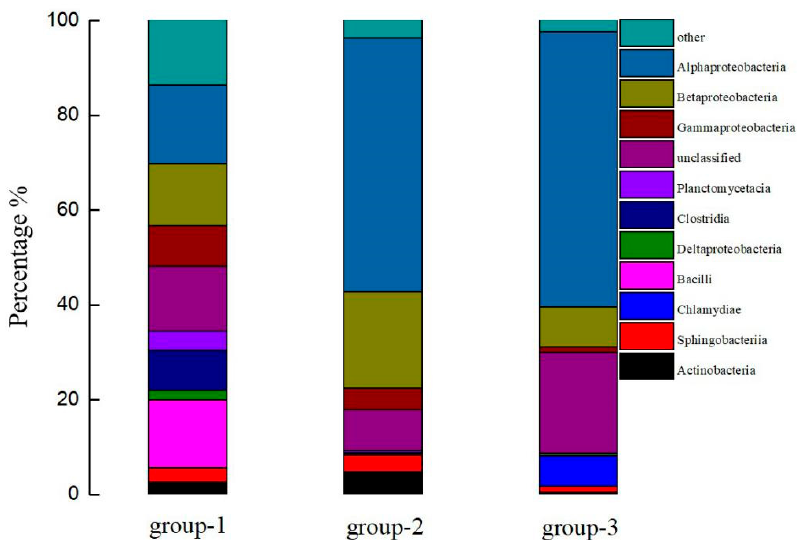
Figure 9. The relative percentages of the community constitution at the class level.